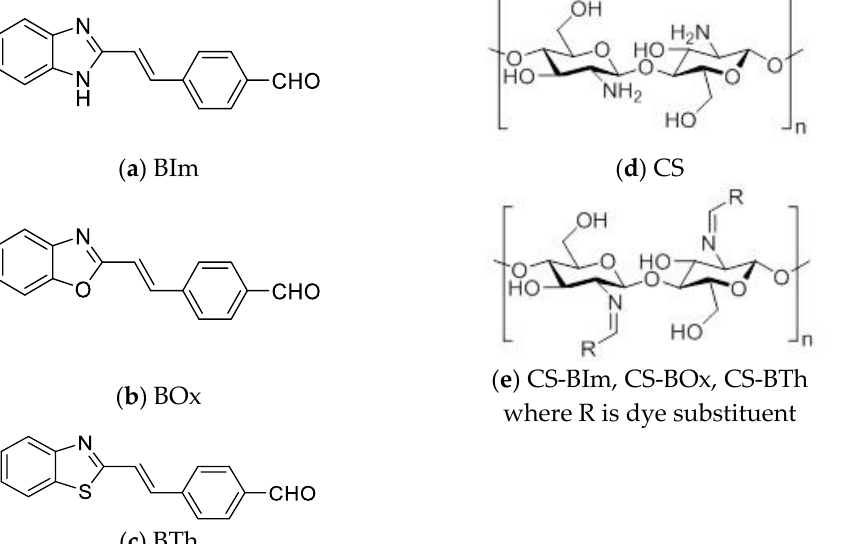
Figure 1. Structure of studied compounds — dye: BIm ( a ), BOx ( b ), and BTh ( c ); initial chitosan as a reference ( d ) and fluorescent chitosan CS-BIm, CS-BOx, and CS-BTh ( e ).